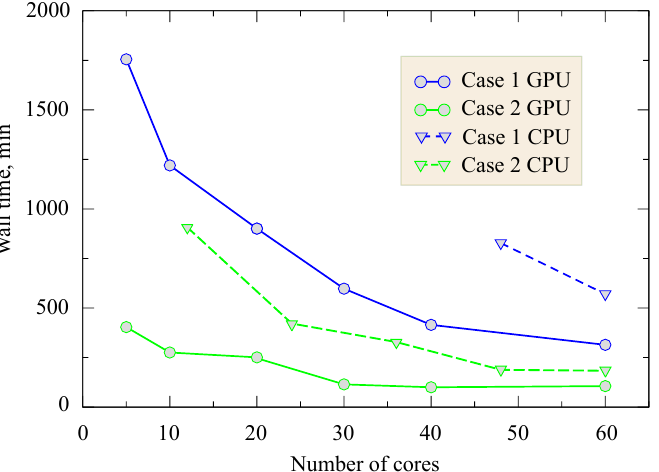
Figure 2. Wall time as a function of core number for different cases used for test calculations. Computational acceleration as a function of MPI core number. Case 1 (hard case) is the monolayer (4 Cr and 12 I atoms) k-points mesh 18 × 18 × 1 (164 k-points in total) and vacuum space 43 Å . Case 2 (mild case) is the single layer of CrI 3 (25 k-points in total) where smaller vacuum space 25 Å and loosened 7 × 7 × 1 k-points mesh have been applied along with US